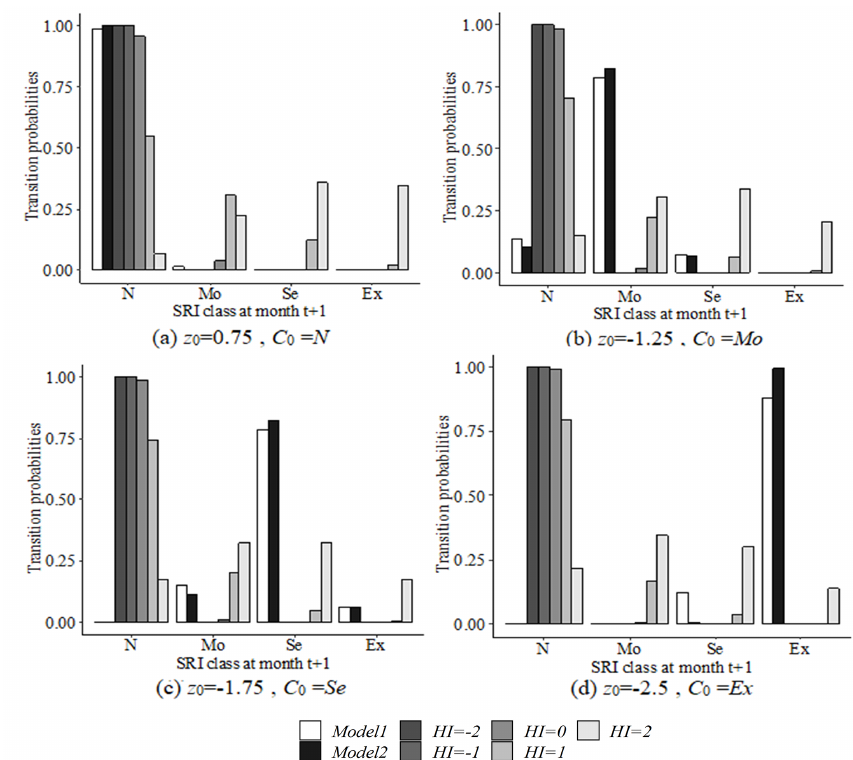
Figure 6. Drought transition probability under the influence of human activities ( C 0 denotes the initial drought class of the SPI in the multivariate normal model; z 0 represents the initial value of the SPI in the conditional distribution model; Model 1: the normal distribution model; Model 2: the conditional distribution model; Model 3: the conditional distribution model involving the HI).